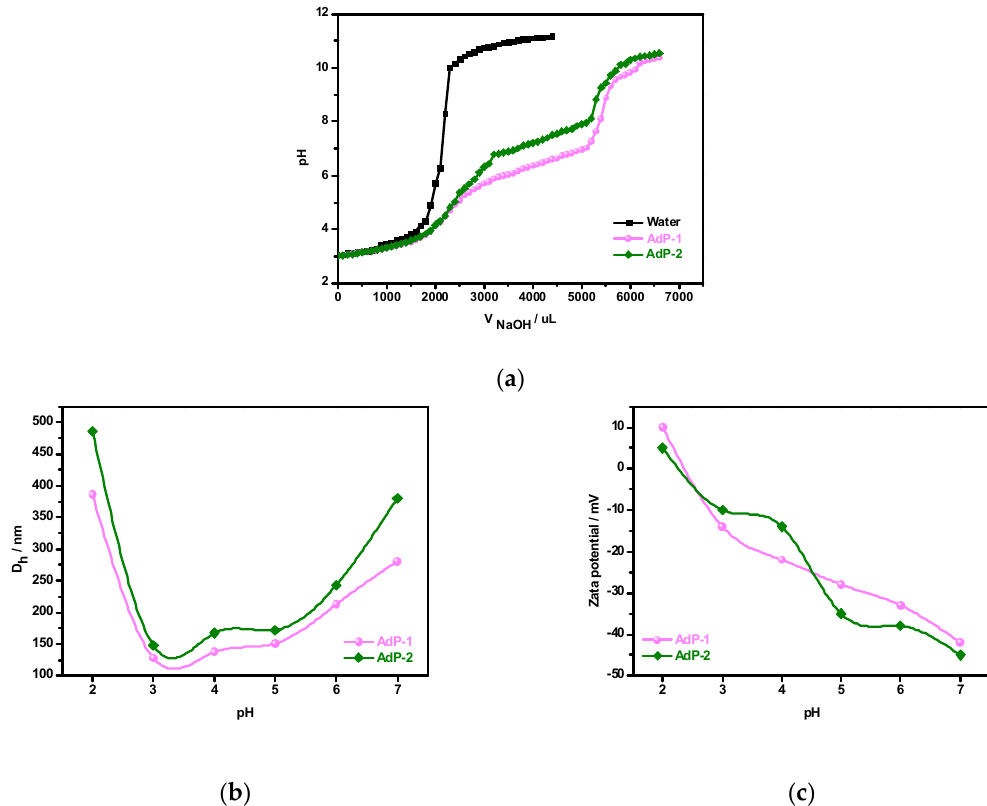
Figure 3. Titration curves ( a ); Effects of pH on D h ( b ) and zeta potential ( c ) of the micelles formed by Ad-P1 and AdP-2.